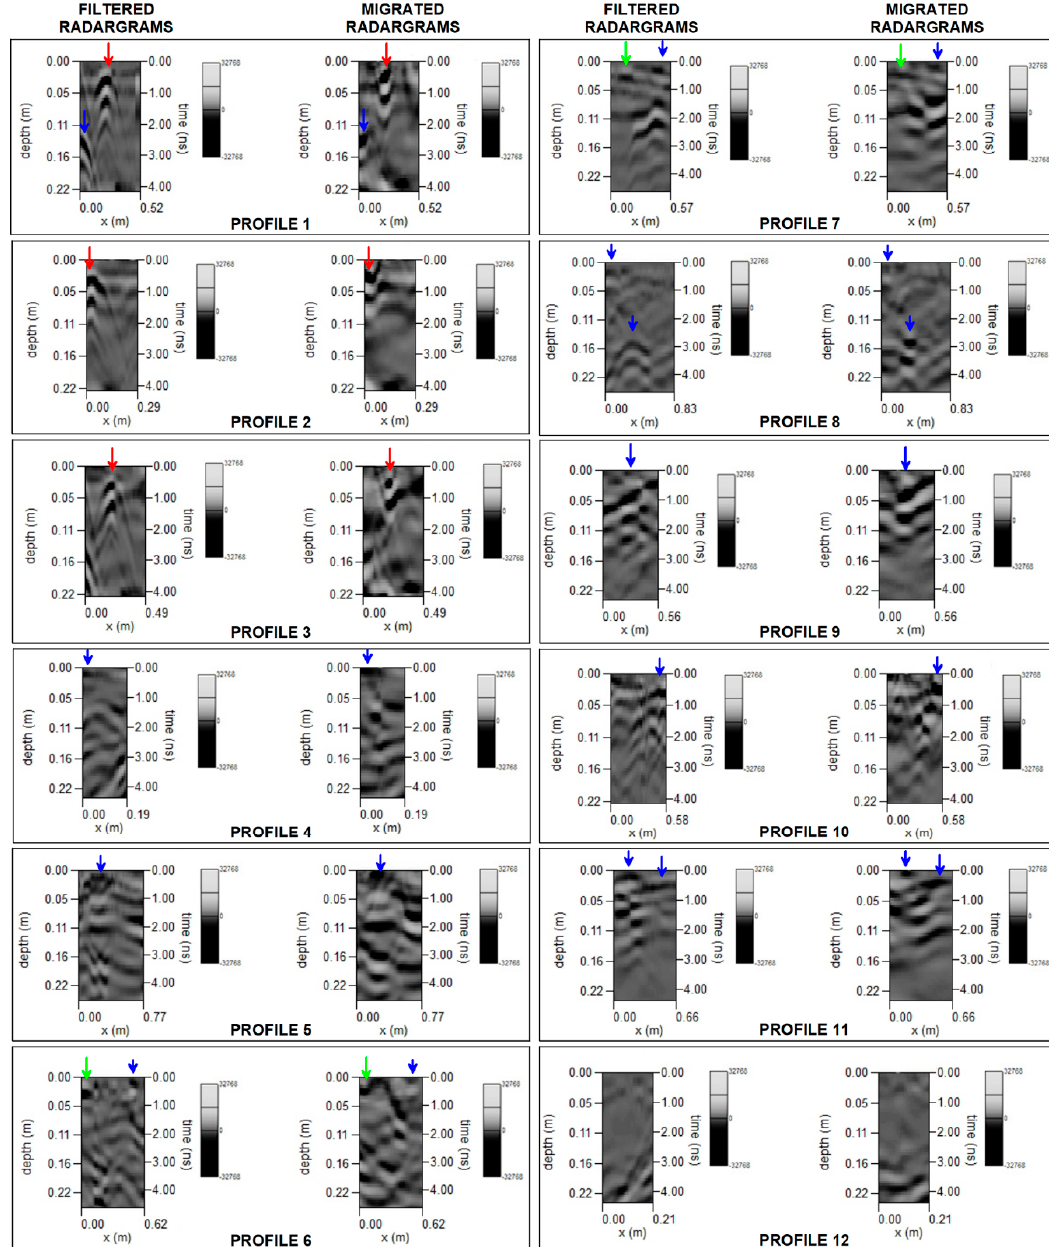
Figure 9. Filtered and migrated radargrams of profiles 1–12.